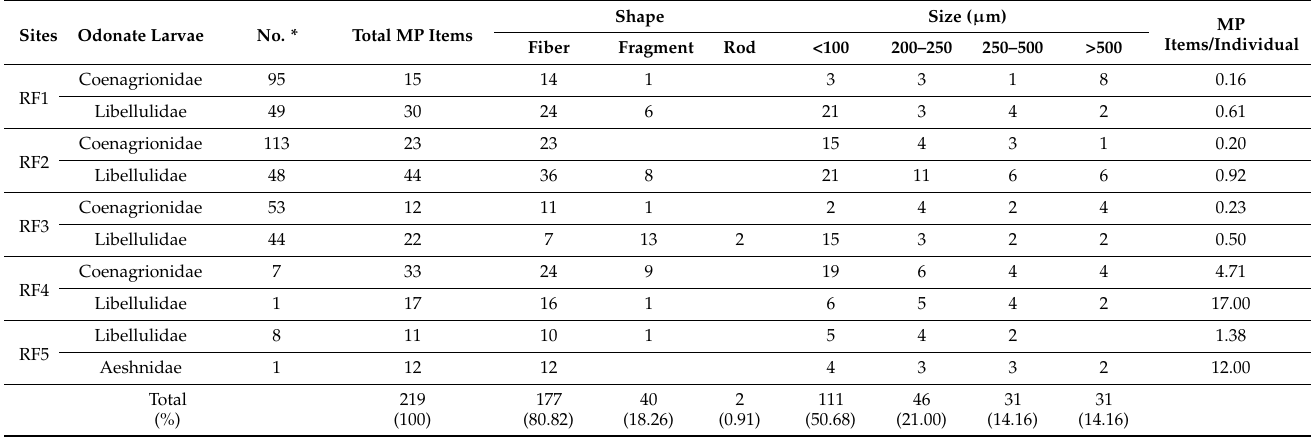
Table 5. Shape and size distribution of microplastics in odonate larvae from rice fields.